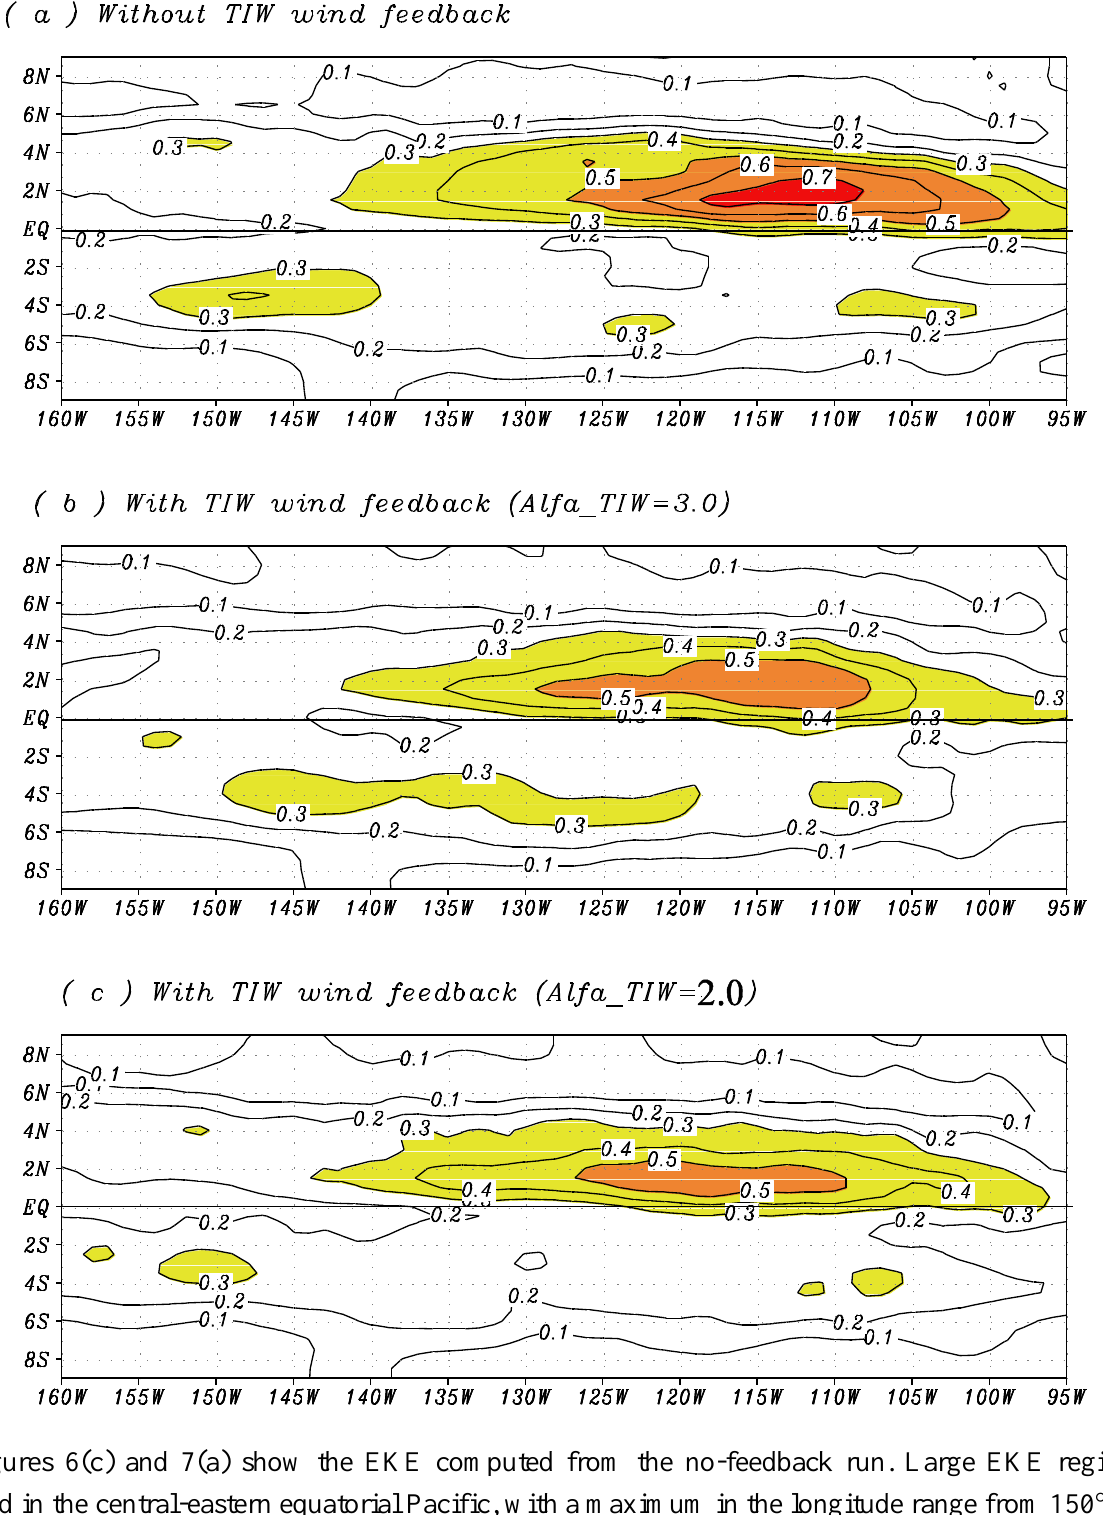
Figure 5. Horizontal distributions for the standard deviation (sdv) of SST from ( a ) the no-feedback run and from the TIW wind feedback runs with ( b ) α ( c ) α = 2.0, respectively. The calculations are made from daily SST TIW The contour interval is 0.1